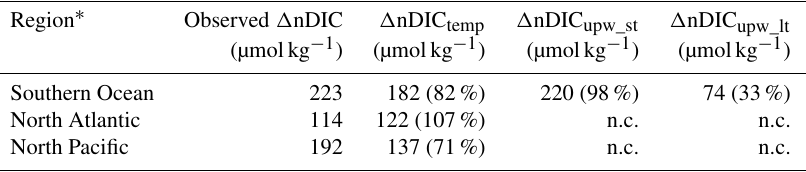
Table 4. Summary of nDIC differences between low and high latitudes. Each (cid:49) nDIC value is the amount by which the annual average nDIC value for the high-latitude region exceeds the annual average value for the low latitudes (30 ◦ S to 30 ◦ N). Percentages in brackets represent the proportion of the observed nDIC difference in the second column; n.c.: not calculated. Region ∗ Observed (cid:49) nDIC (cid:49) nDIC temp (cid:49) nDIC upw_st (cid:49) nDIC upw_lt (µmolkg − 1 ) (µmolkg − 1 ) (µmolkg − 1 ) (µmolkg − 1 ) Southern Ocean 223 182 (82%) 220 (98%) 74 (33%) 114 122